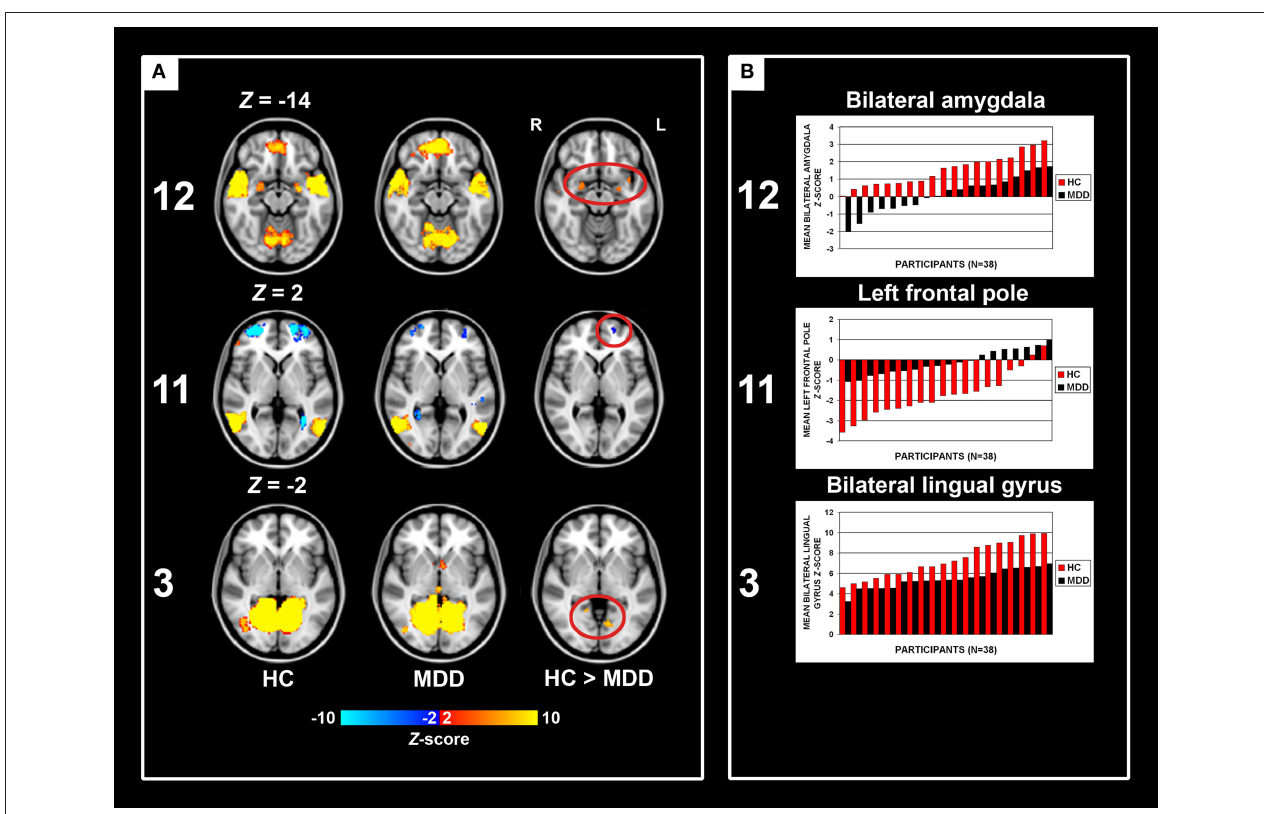
connectivity in the MDD group. RSN 3 shows MDD-related decreased connectivity of the bilateral lingual gyrus with other medial visual areas. Images are z -statistics, ranging from 2 to 10, overlaid on the MNI-152 standard brain. The left hemisphere of the brain corresponds to the right side in this image. HC, healthy controls; MDD, major depressive disorder. (B) Distribution of the mean individual z -scores within the bilateral amygdala (12), left frontal pole (11), and bilateral lingual gyrus (3). Depicted in red are the controls, in black the MDD group, both sorted from smallest to highest z